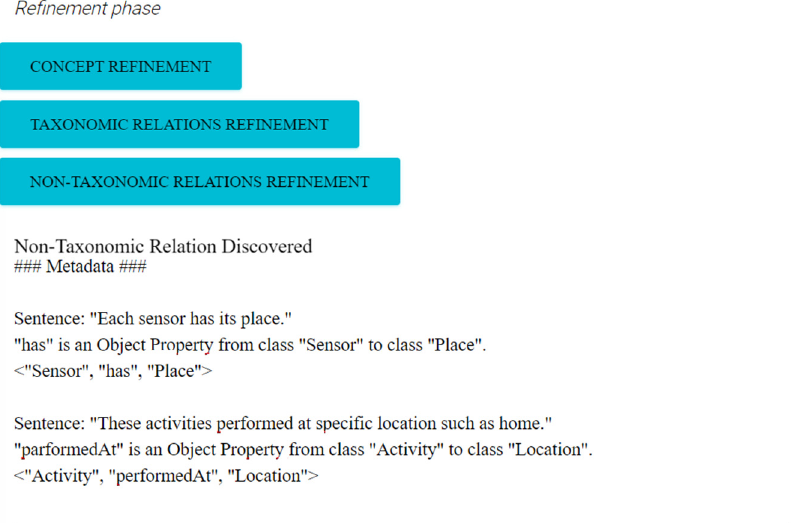
Figure 20. Ontology-based model learning at t 2 in the refinement phase, an example of non- taxonomic refinements.